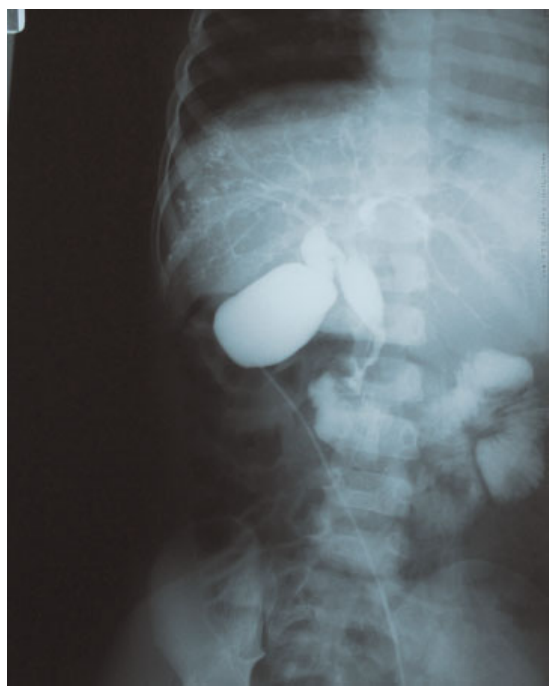
Fig. 1 Operative cholangiography shows pancreaticobiliary maljunction and a choledochal cyst.